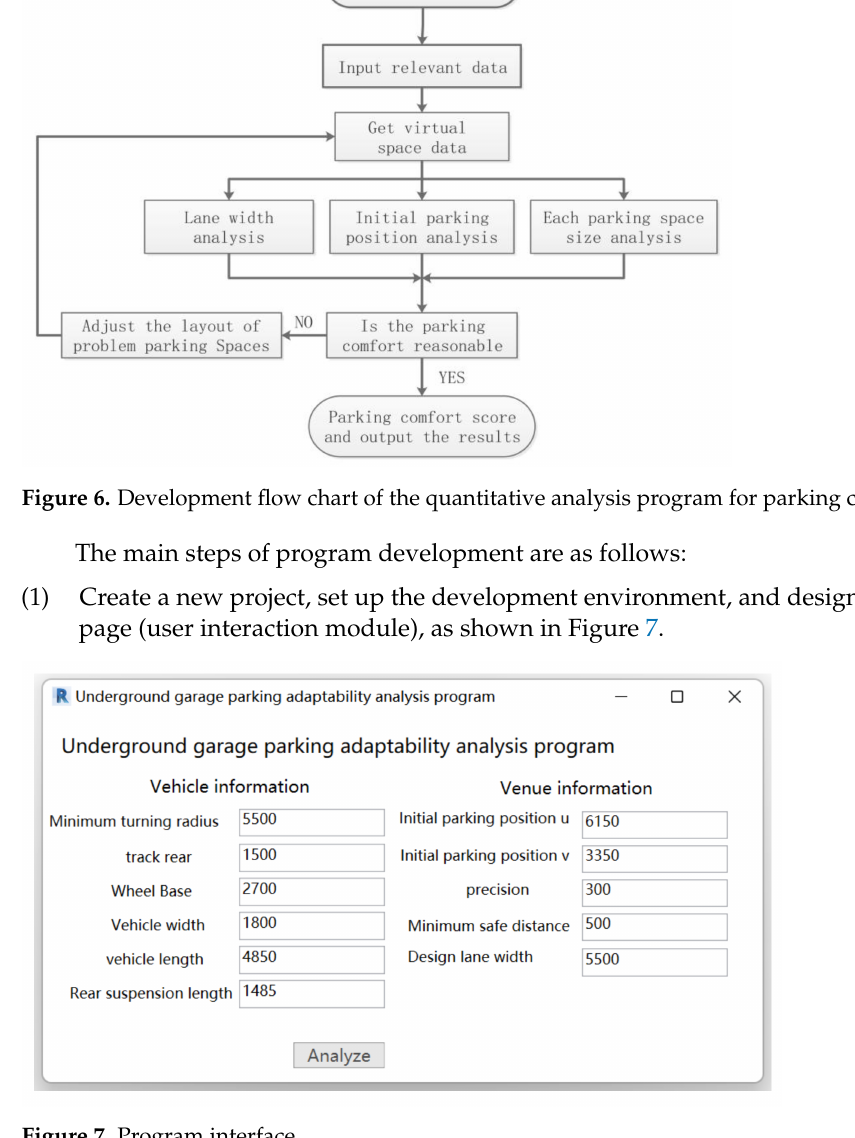
Figure 7. Program